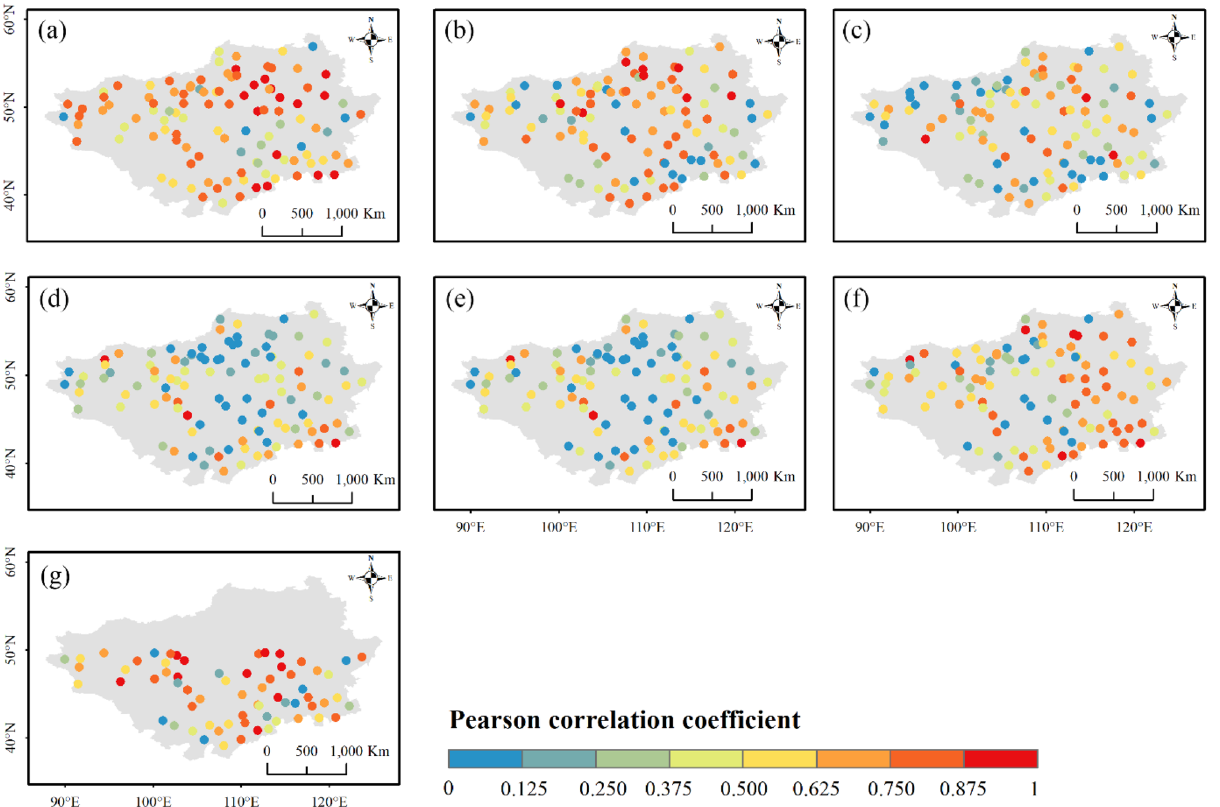
Figure 3. Pearson correlation coefficients between precipitation interannual variability from stations and ( a ) ERA5-Land, ( b ) ERA5-HRES, ( c ) ERA-Interim, ( d ) IMERG ER, ( e ) IMERG LR, ( f ) IMERG FR, and ( g ) TMPA-3B42. For subplot ( g ), only stations within the spatial coverage of TMPA-3B42 (50° N–50° S) were plotted. The figure was created using ArcGIS 10.7 (https:// www. esri. com/ en- us/ arcgis/ about- arcgis/ overv iew) 70